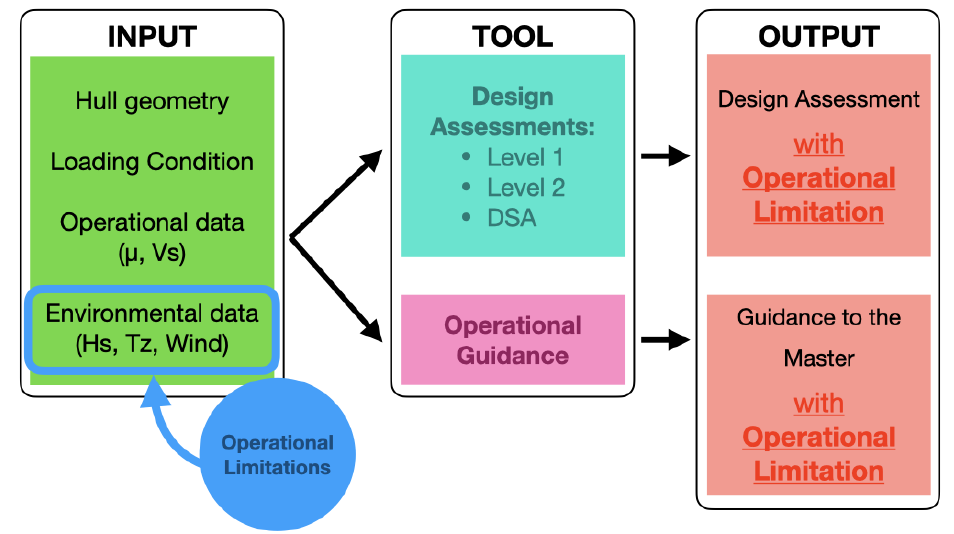
Figure 2. Scheme of the logical concept for Operational Limitations